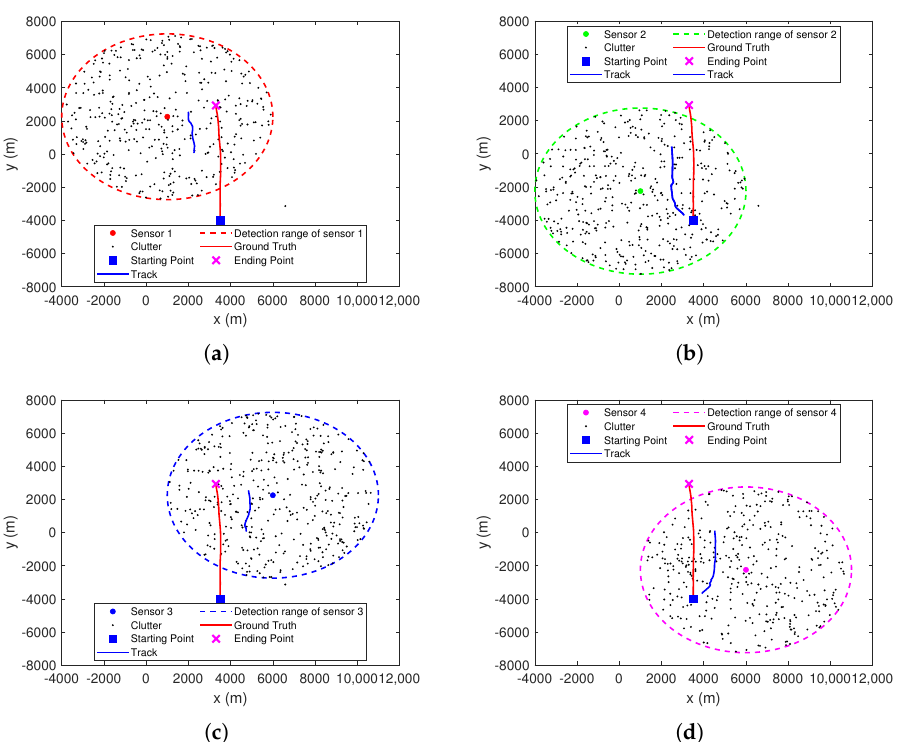
Figure 13. Tracking results of first stage MHT in each local sensor. ( a ) Sensor 1. ( b ) Sensor 2. ( c ) Sensor 3. ( d ) Sensor